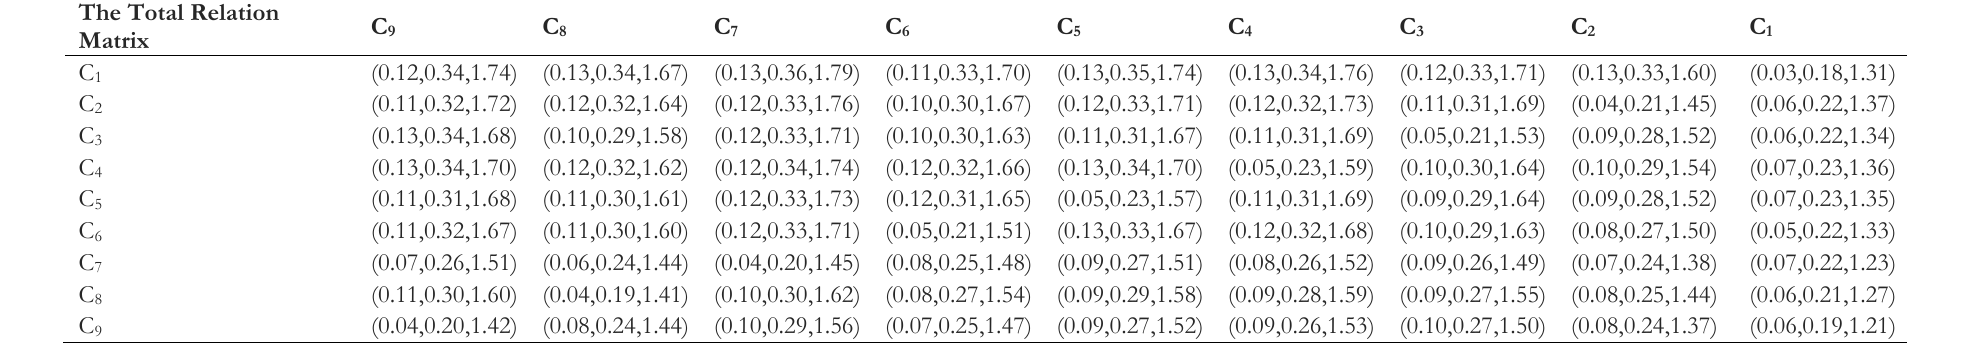
Table 6. The total relation